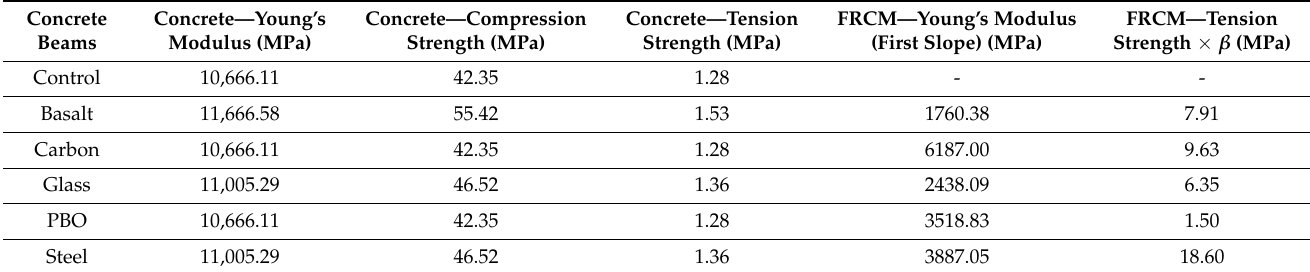
Table 6. Input materials properties to simulate unstrengthened and strengthened